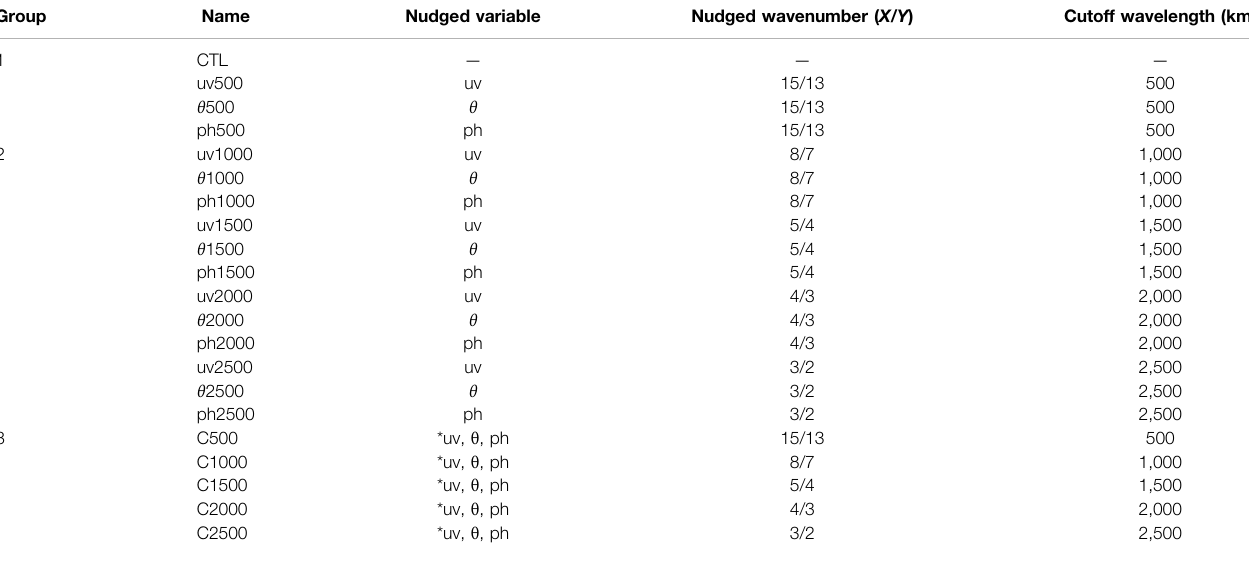
TABLE 1 | Experiment design ( X -zonal direction, Y -meridional direction, uv denotes horizontal wind, θ denotes potential temperature, and ph denotes geopotential height. Nudged variables for Group 3 were selected based on the simulation performance of Groups 1 and 2). Group Name Nudged variable Nudged wavenumber ( X / Y ) Cutoff wavelength